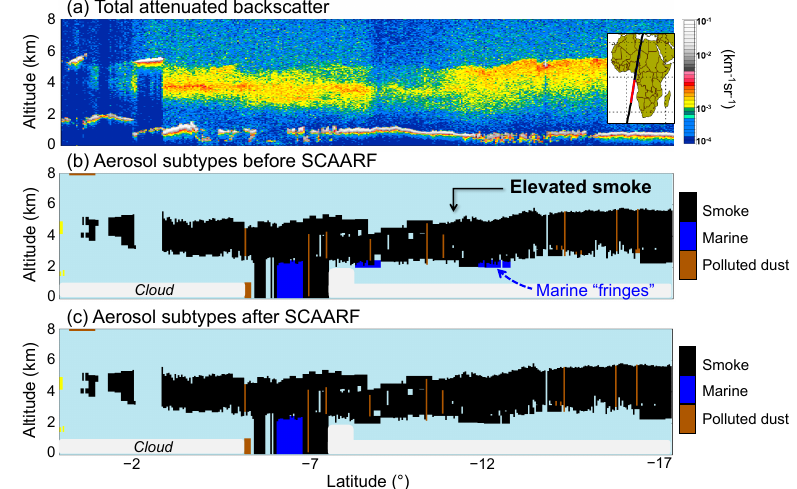
Figure 10. CALIOP observations of a smoke plume off the west coast of Africa on 14 September 2008 from approximately 01:08 to 01:10UTC. (a) Total attenuated backscatter 532nm and aerosol subtype classification (b) before and (c) after SCAARF is implemented. The inset map in (a) shows the CALIOP ground track in red. Aerosol subtypes elevated smoke (black), clean marine (blue), and polluted dust